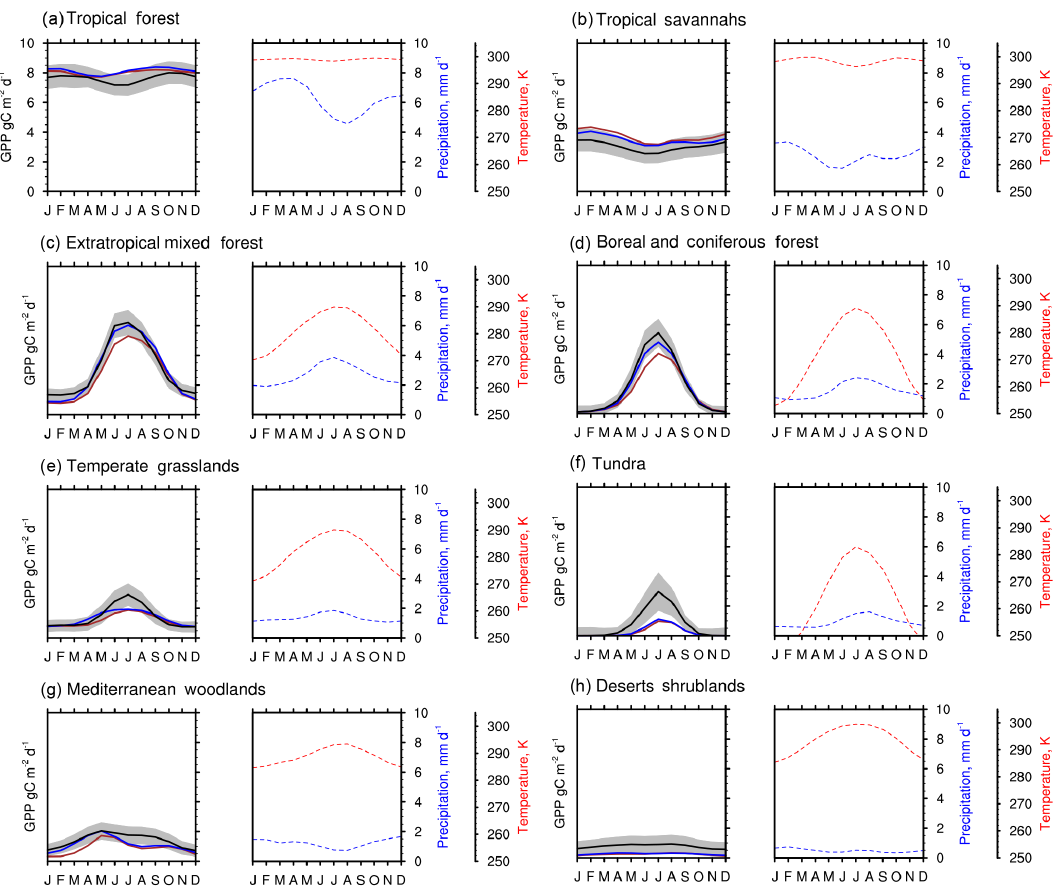
Figure 7. Area-averaged seasonal cycles of GPP from the biomes shown in Fig. 3b, comparing JULES5, JULES9, and the Jung et al. (2011) MTE. Also shown are the temperature and precipitation from the CRU-NCEP data set used to force the JULES simulations. The gray shading in the GPP plots shows the MTE GPP ± 1 standard deviation based on the area-averaged standard deviations of monthly fluxes for each grid